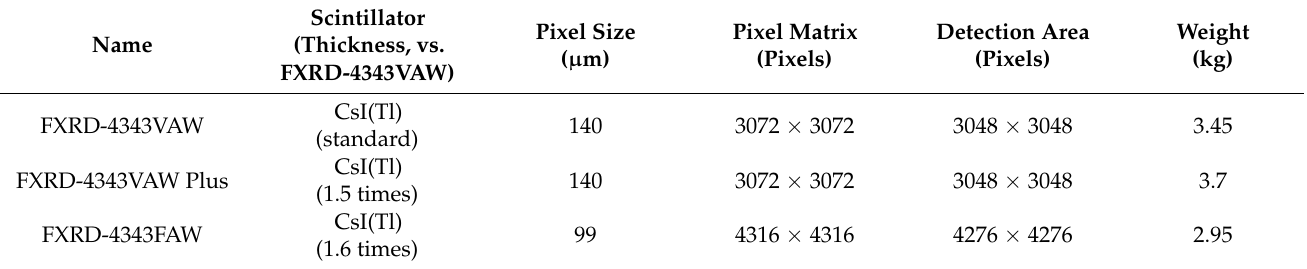
Table 1. Detector specifications for the experiment.